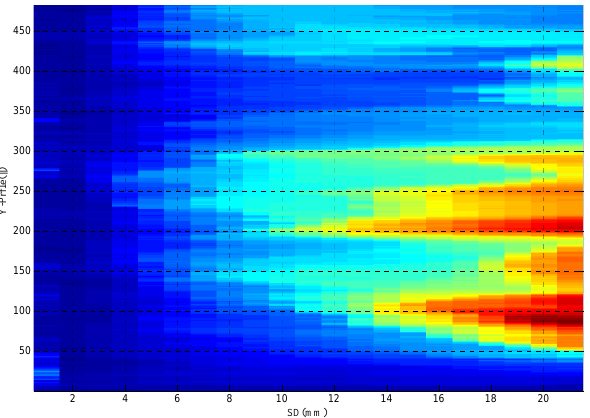
Figure 4. Development of the logarithmic scale of the node’s degree over parallel- Fig. 4. Development of the logarithmic scale of the node’s degree aperture profiles (vertical axis is proportional with Y- axis) with shear slips (SD: in mm - over parallel-aperture profiles (vertical axis is proportional with Y- horizontal axis). Rapid growth of links occurs in portion of aperture patches. axis) with shear slips (SD: in mm – horizontal axis). Rapid growth of links occurs in portion of aperture